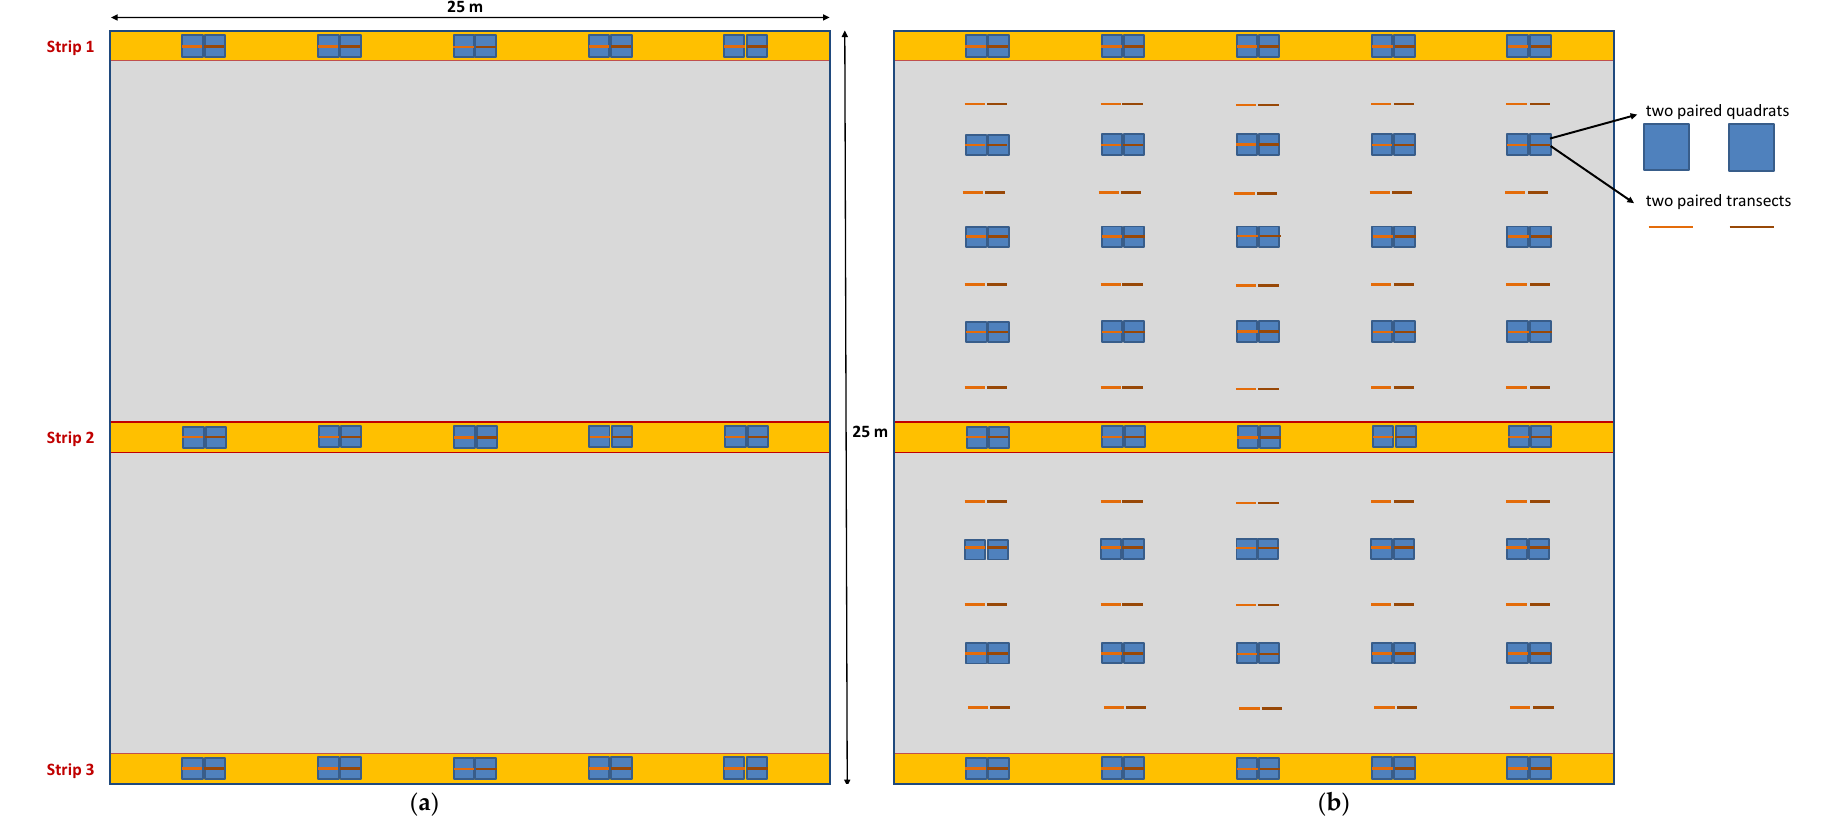
Figure 1. Schematic representation of the Test Zone and the sampling done: ( a ) comparison of line-intersect sampling (LIS) (two 0.7 m transects paired per plot, orange-brown lines, for a total of 30 transects) and fixed-area sampling (FAS) (two 0.46 m 2 quadrats paired per plot, blue squares, for a total of 30 quadrats) with a Reference Strips (orange rectangles), ( b ) estimation of biomass on the whole area of the Test Zone.